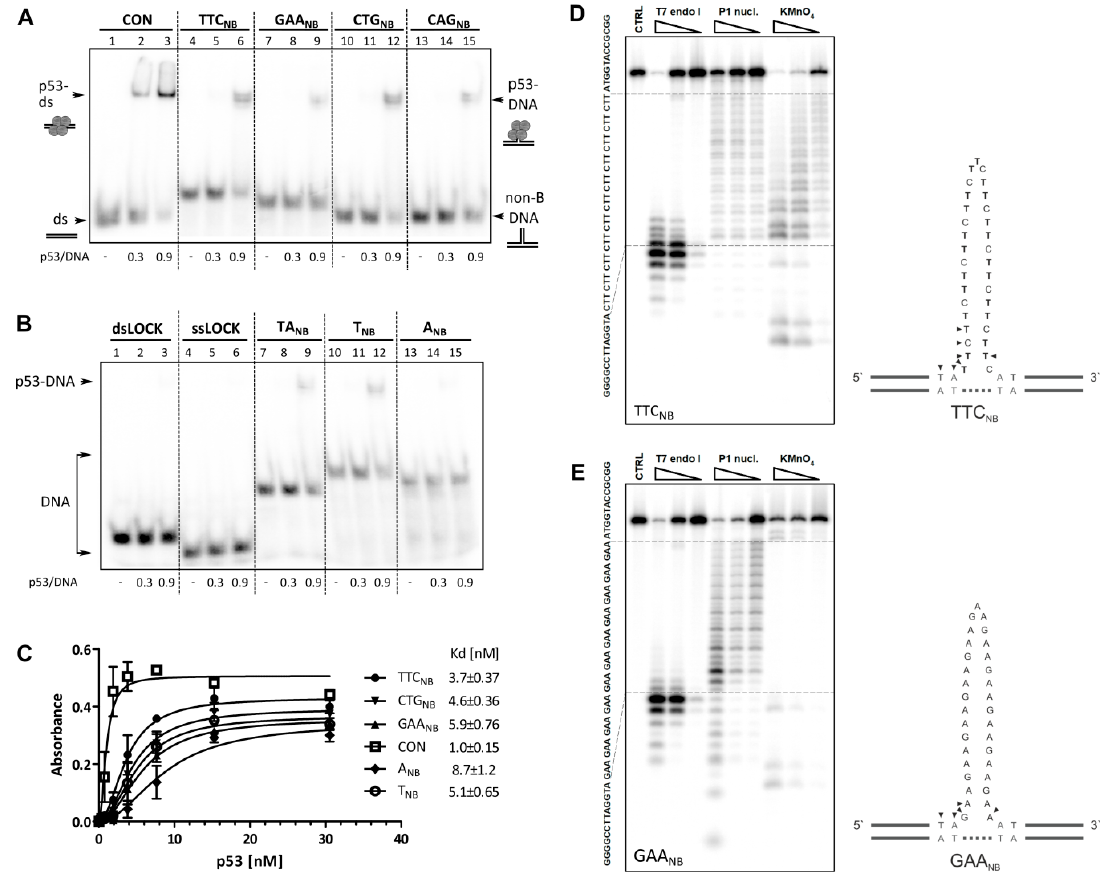
Figure 1. Full length p53 binding to non-B DNA formed by repetitive sequences. Analysis of p53 binding to DNA molecules containing various sequences and structures. DNA sequences are provided in Table S1. In panels ( A ) and ( B ), radiolabeled oligonucleotides (1 pmol) were bound by p53 in binding buffer in the presence of non-specific DNA competitor (75 ng, BSK/SmaI) and analyzed on a 6% 0.5× TBE polyacrylamide gel. The p53/DNA ratios are given per p53 tetramer. ( A ) DNA molecules are slipped strand mimicking substrates formed by trinucleotide repeat sequences (11 repeats of TTC, GAA, CTG or CAG) and a duplex p53 consensus sequence (CON). ( B ) DNA molecules formed by TA NB , T NB , A NB , and DNA sequence nonspecific for p53 (dsLOCK, ssLOCK). ( C ) p53 binding to biotinylated oligonucleotides by ELISA, portrayed are mean values and SD. The dissociation constants (Kd) calculated per p53 tetramer are indicated. ( D , E ) Polyacrylamide gels showing resolved products of TTC NB ( D ) and GAA NB ( E ) enzymatic or chemical cleavage with increasing concentration of T7 endonuclease I (left), P1 nuclease (middle) and potassium permanganate followed by piperidine treatment (right). Right panels show schematic drawings of formed structures. Small arrows indicate preferential cleavage by T7 endonuclease I.